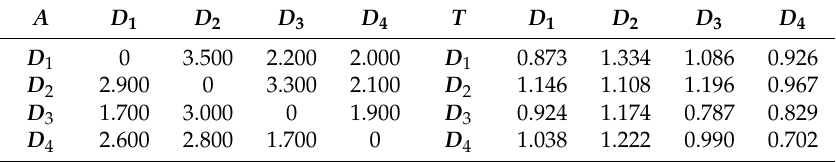
Table 1. Average direct-influence relation matrix and total influence relation matrix of each dimension.